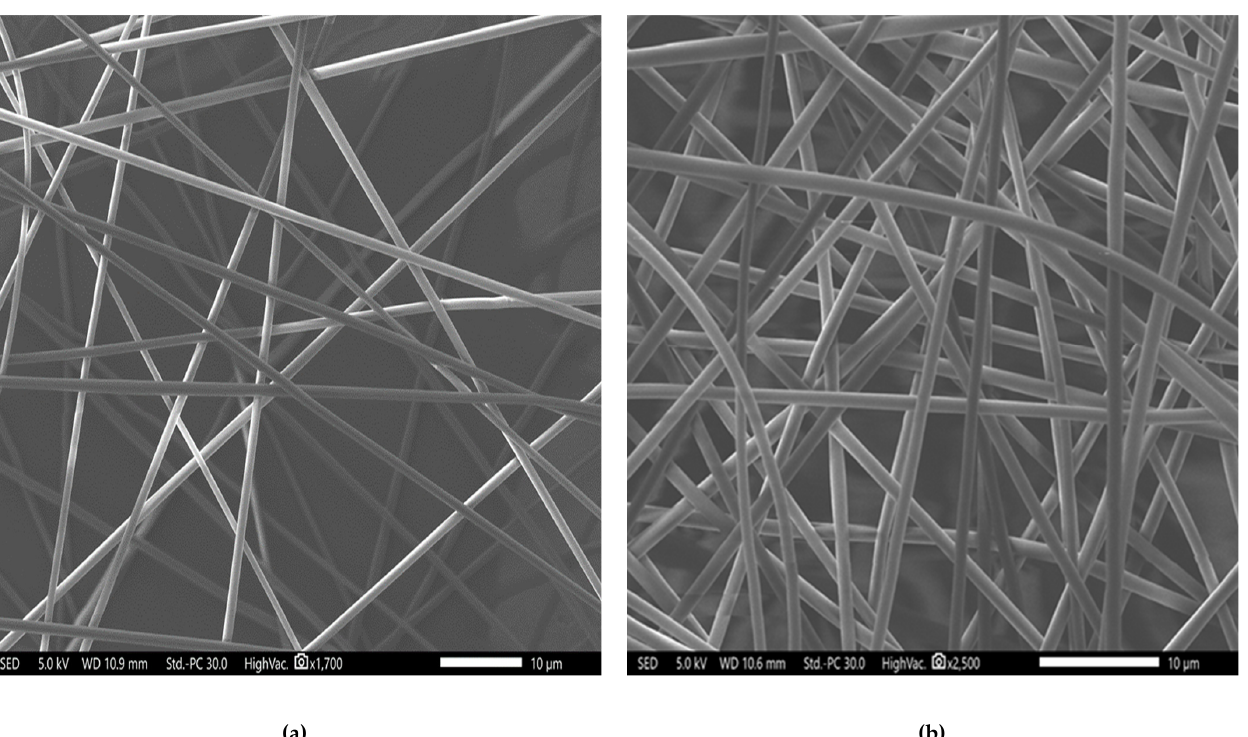
Figure 2. SEM images of blank ( a ) and melittin-loaded ( b ) fibers showed that both fibrous systems had smooth surfaces with no signs of bead or pores, with average diameters of 990 ± 130 nm, 1030 ± 160 nm, respectively.